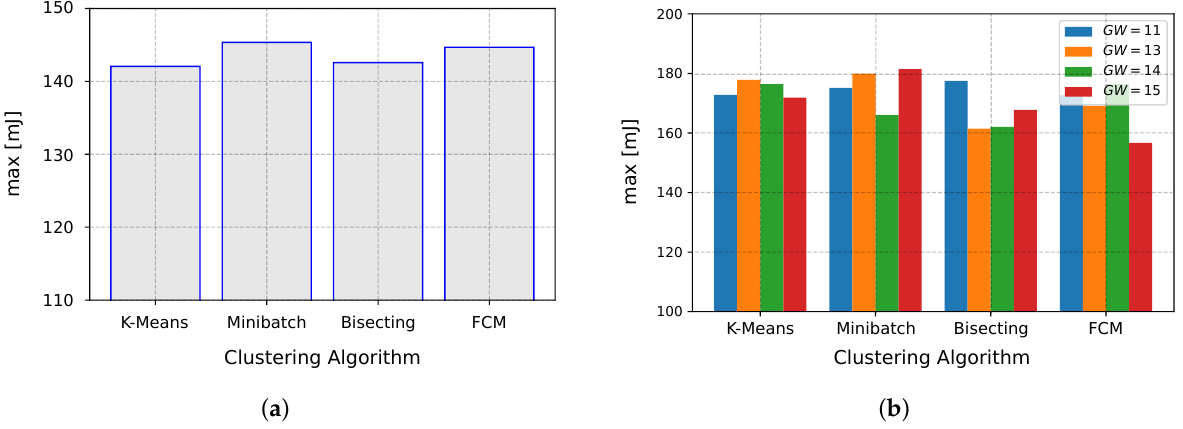
Figure 13. Maximum energy consumption for the best p -value situation considering ( a ) Scenario 1 (two GWs), and ( b ) Scenario 2 (GW